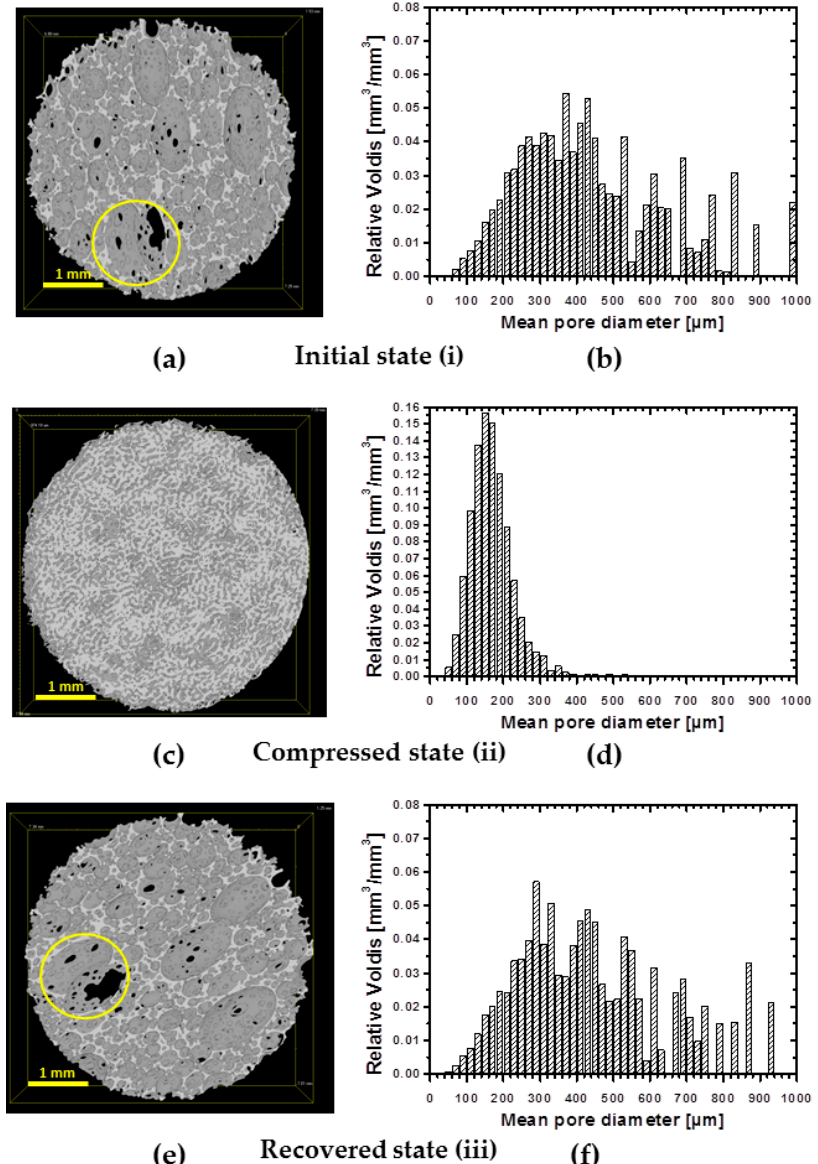
Figure 9. Three-dimensional imaging of initial state of the cPCL-2/8k-170 specimen ( a ); specimen compressed in situ to 60% cPCL-2/8k-170 ( c ); and recovered specimen cPCL-2/8k-170 ( e ). The respective pores volume distribution are given for: initial ( b ); compressed ( d ); and recovered ( f ) states. Yellow circles indicate the same site in the foam in its initial and recovered states.